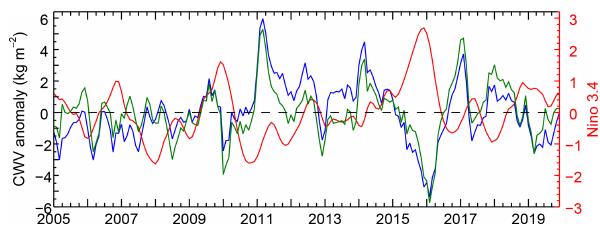
Figure 3. Time series of (red) ONI index and monthly mean CWV anomalies derived from (blue) radiosonde observation and (green) reanalysis data at five radiosonde stations.